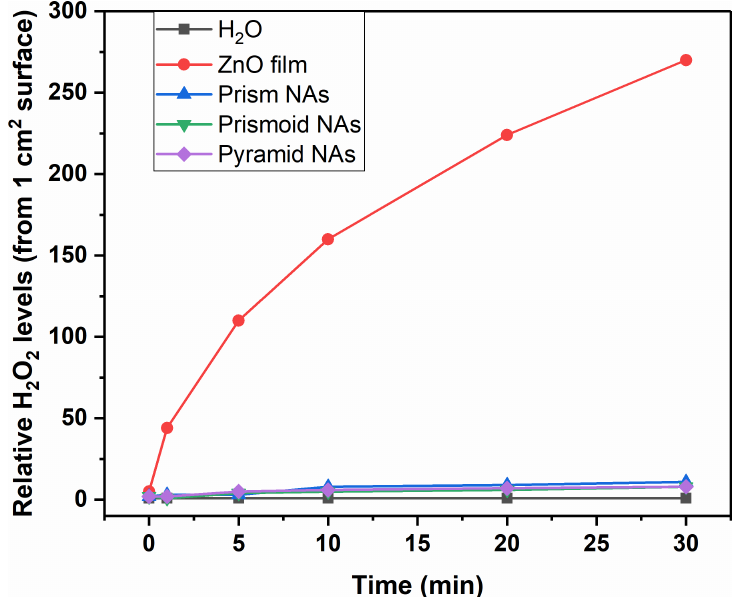
Figure S5: Production of H 2 O 2 of ZnO film and three ZnO NAs as the function of time.